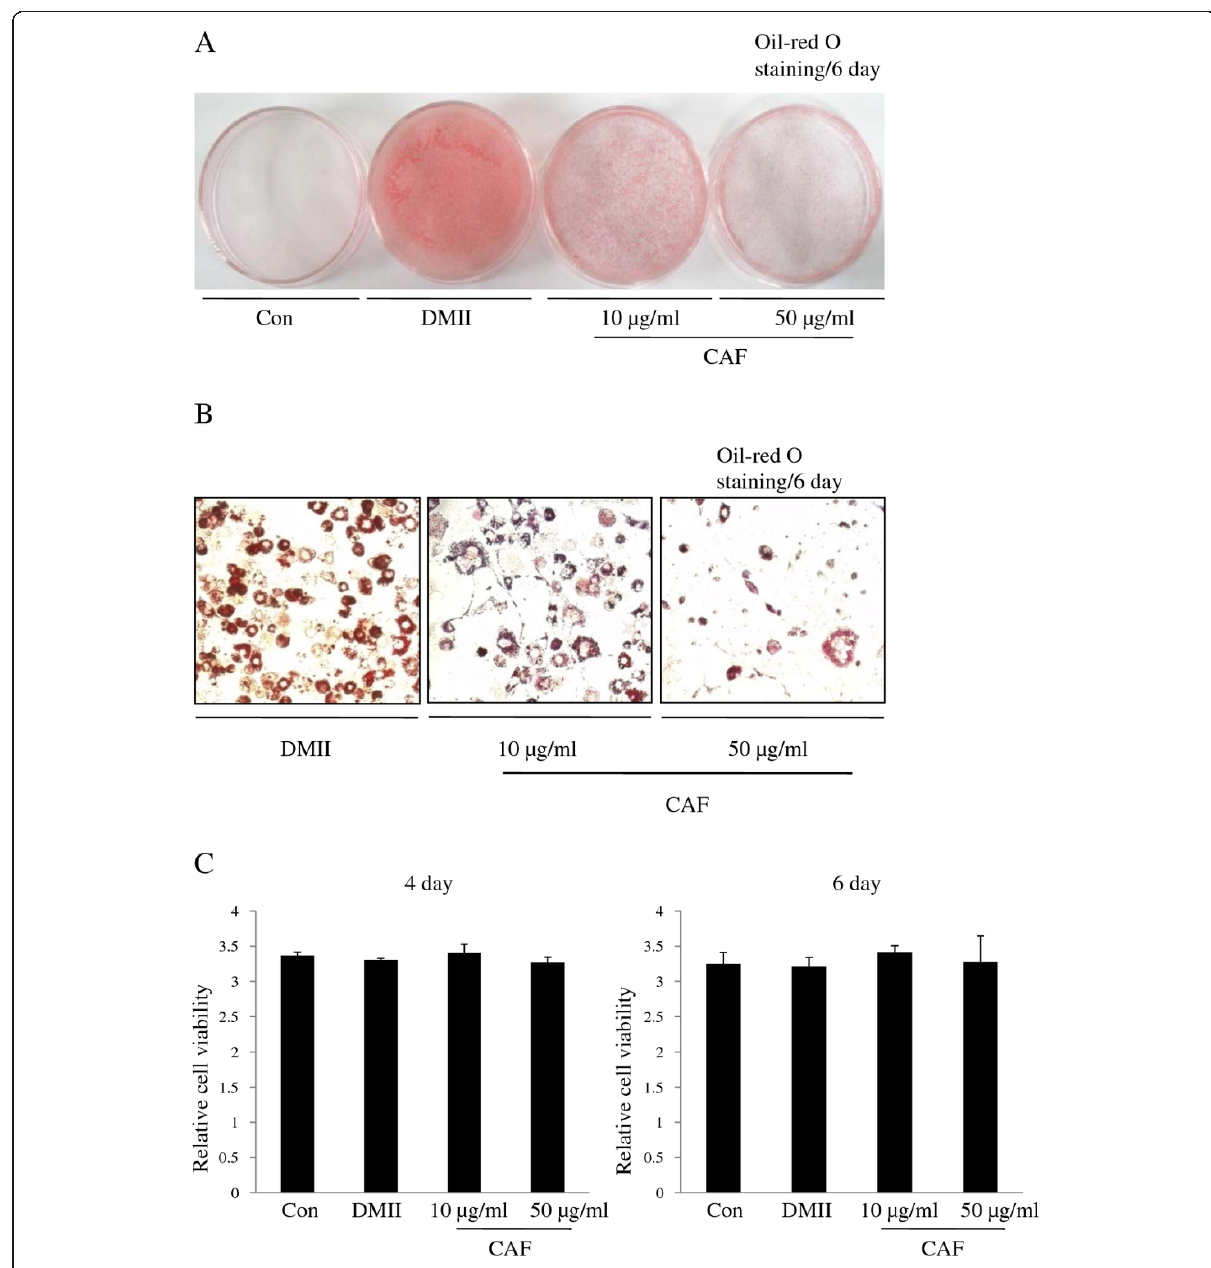
Figure 1 Effect of CAF on lipid accumulation of 3T3-L1 adipocytes . Confluent 3T3-L1 preadipocytes differentiated into adipocytes in medium containing different concentrations of CAF for 6 days (from day 0 to 6). Con, 3T3-L1 preadipocytes; DMII, fully differentiated adipocytes; 10 μ g/ml, fully differentiated adipocytes (DMII + 10 μ g/ml CAF); 50 μ g/ml, fully differentiated adipocytes (DMII + 50 μ g/ml CAF). (A, B) Inhibitory effects of CAF on lipid accumulation in 3T3-L1 adipocytes. The intracellular lipid accumulation quantified by Oil-red O staining and also optically observed by an inverted microscope. Oil-red O staining assay for lipid droplets was performed on day 6 after induction of differentiation. (C) Effect of CAF on cell viability in preadipocyte and differentiated adipocytes. These data were presented as relative cell viability values. Data are mean ± SD values of at least three independent experiments. Each experiment was performed in